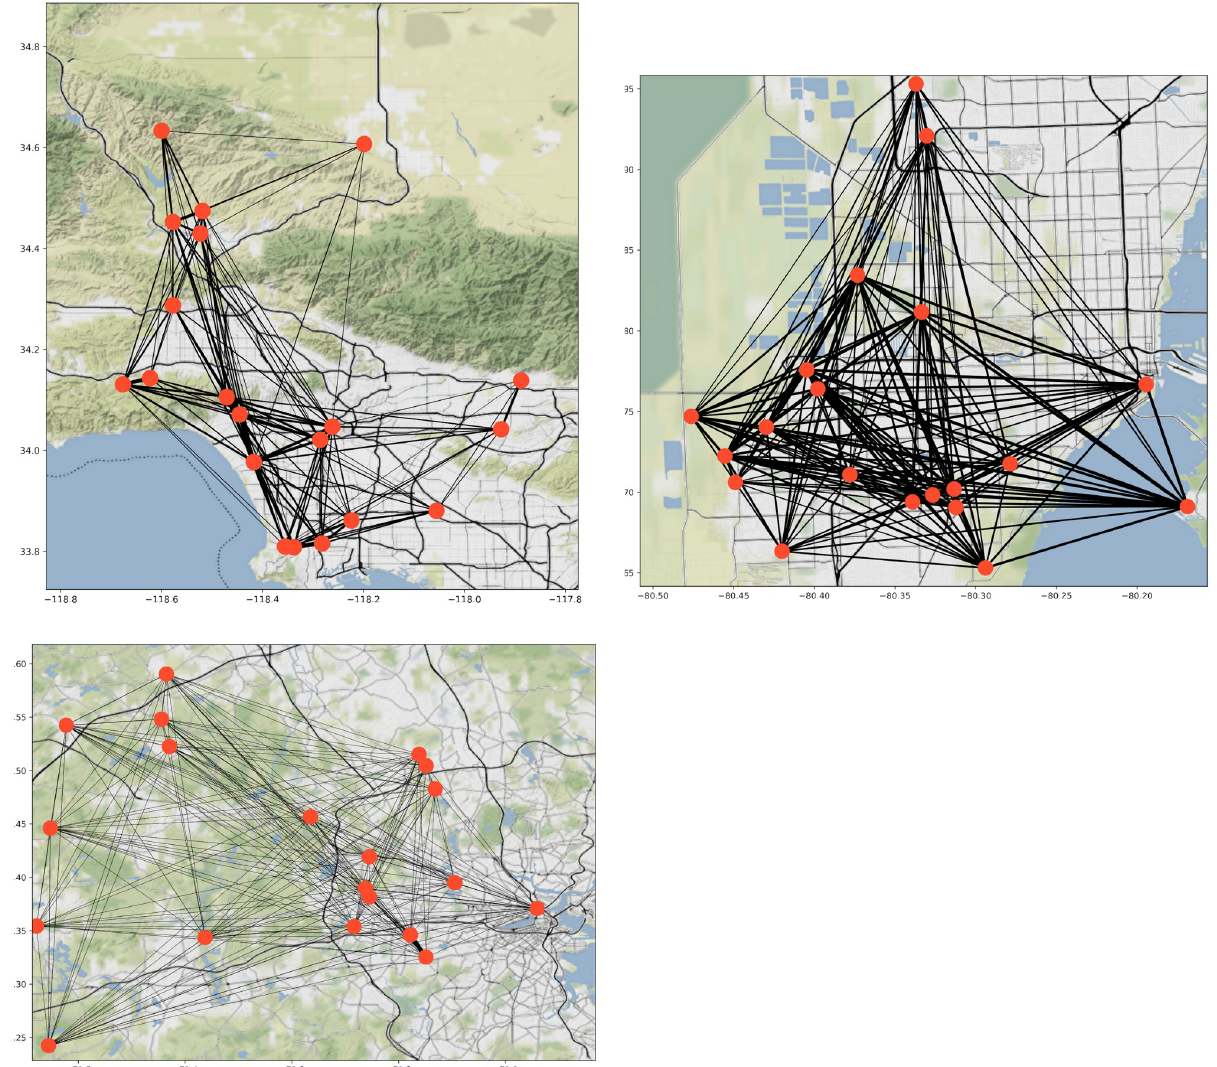
Fig 6. Map overlay of network topologies. Nodes from each CBG are grouped together and placed on the central coordinates for that community. Edges between CBGs represent the sum of all connected edge weights, where darker lines indicate a greater sum of edge weights. Underlying map tiles from Stamen Design under CC BY 3.0. Data by OpenStreetMap, under ODbL [53] (Top left—Los Angeles: http://maps.stamen.com/terrain- background/#10/34.0692/-118.2438. Top right—Miami-Dade: http://maps.stamen.com/terrain-background/#11/25.9046/-80.3070, Bottom— Middlesex: http://maps.stamen.com/terrain-background/#12/42.4205/-71.4415.